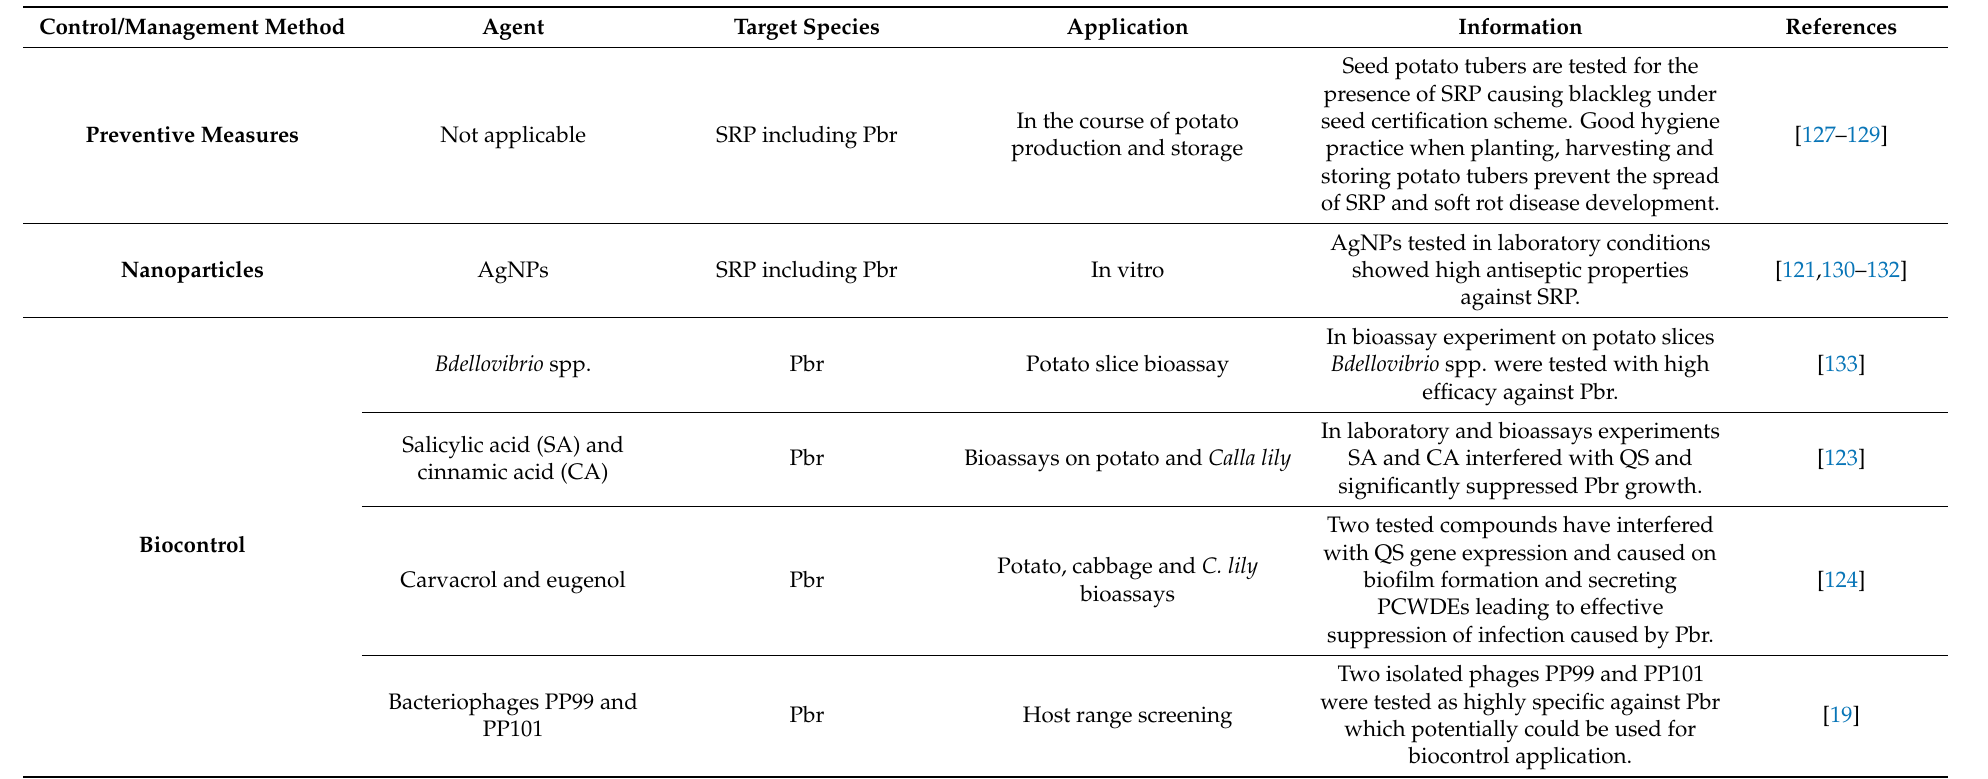
Table 3. Summary of control methods reported to manage